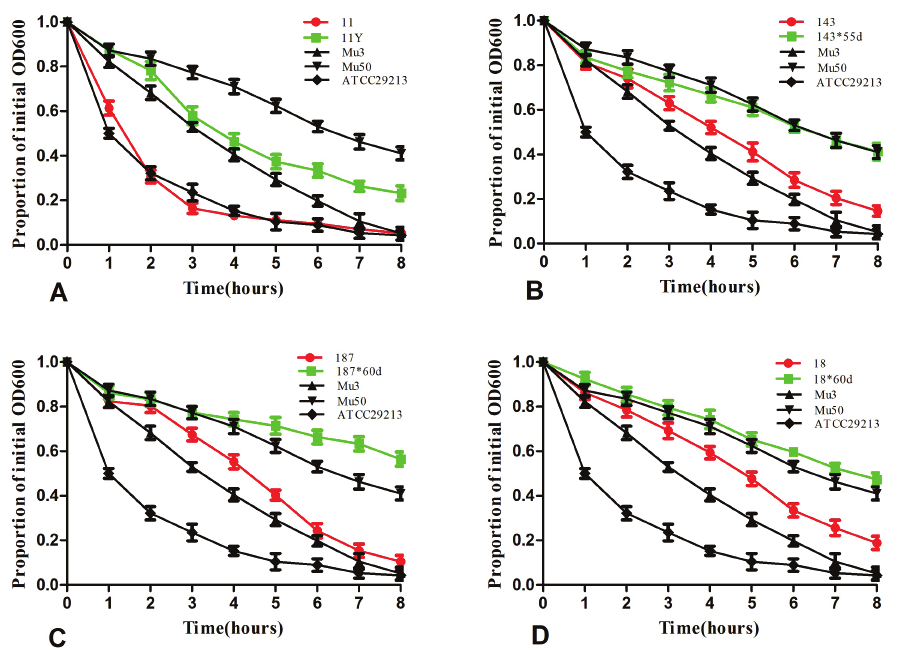
Figure 5: Autolytic assay results of four pairs of parental strains and derivated strains. The results which described as the mean OD values were done in